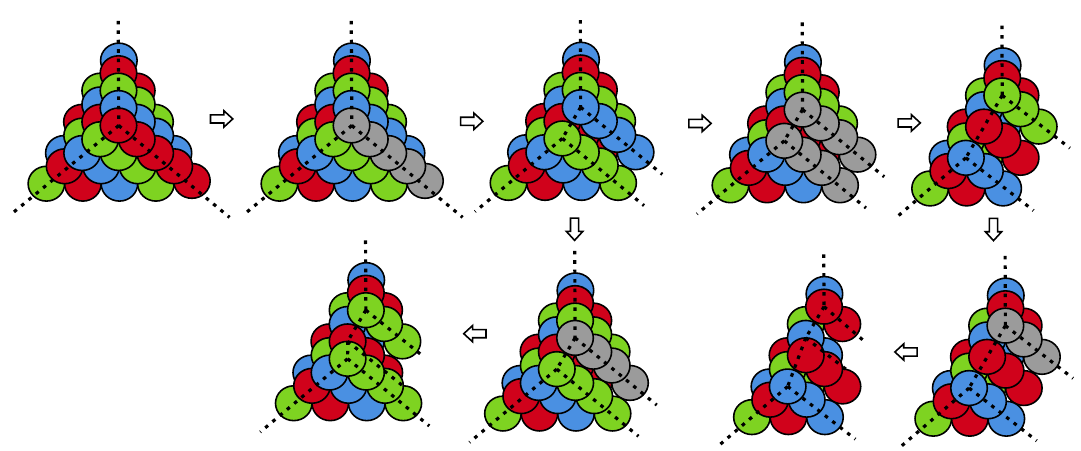
Figure 13 . Peeling off the semi-infinite faces of the C × C 2 / Z 3 crystal. The dashed brane webs is composed of the